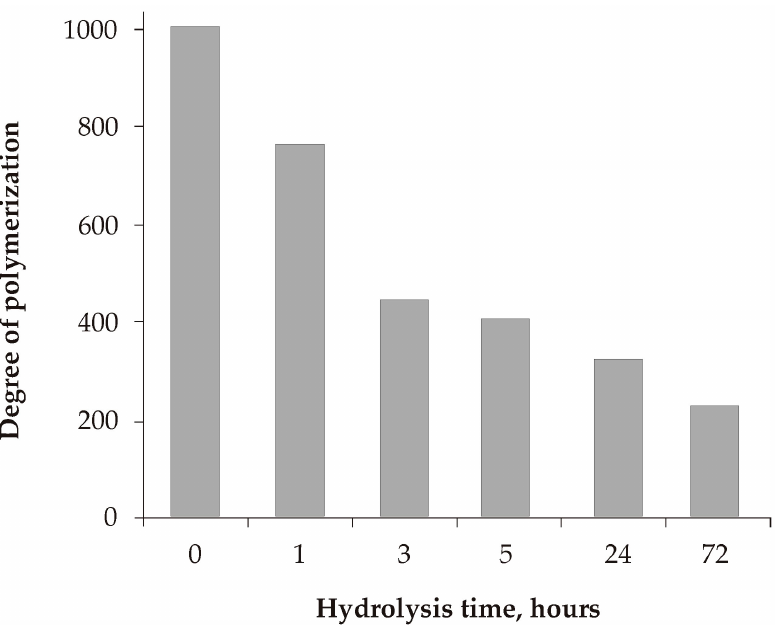
Figure 2. Changes in the degree of polymerization of biomodified kraft pulp during biocatalysis.